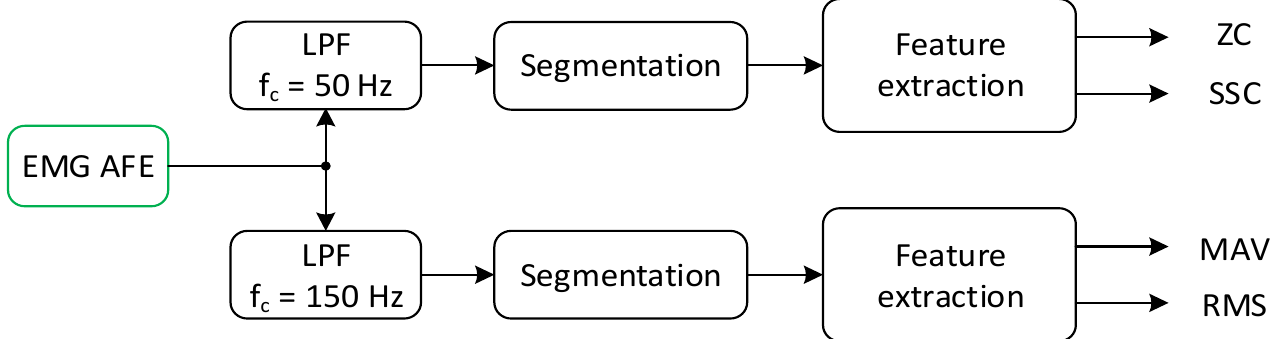
Figure 11. Block diagram of the EMG feature extraction procedure assuming two parallel lowpass filters: 50 Hz lowpass filter for muscular activity and 150 Hz for the muscle activation pattern.